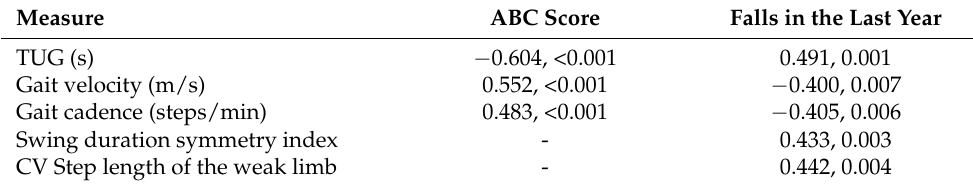
Table 3. Correlations between the fall parameters (activity-specific Balance Confidence Scale = ABC score and number of falls in the last year) and the gait and Timed Up-and-Go (TUG) measures. CV = Coefficient of